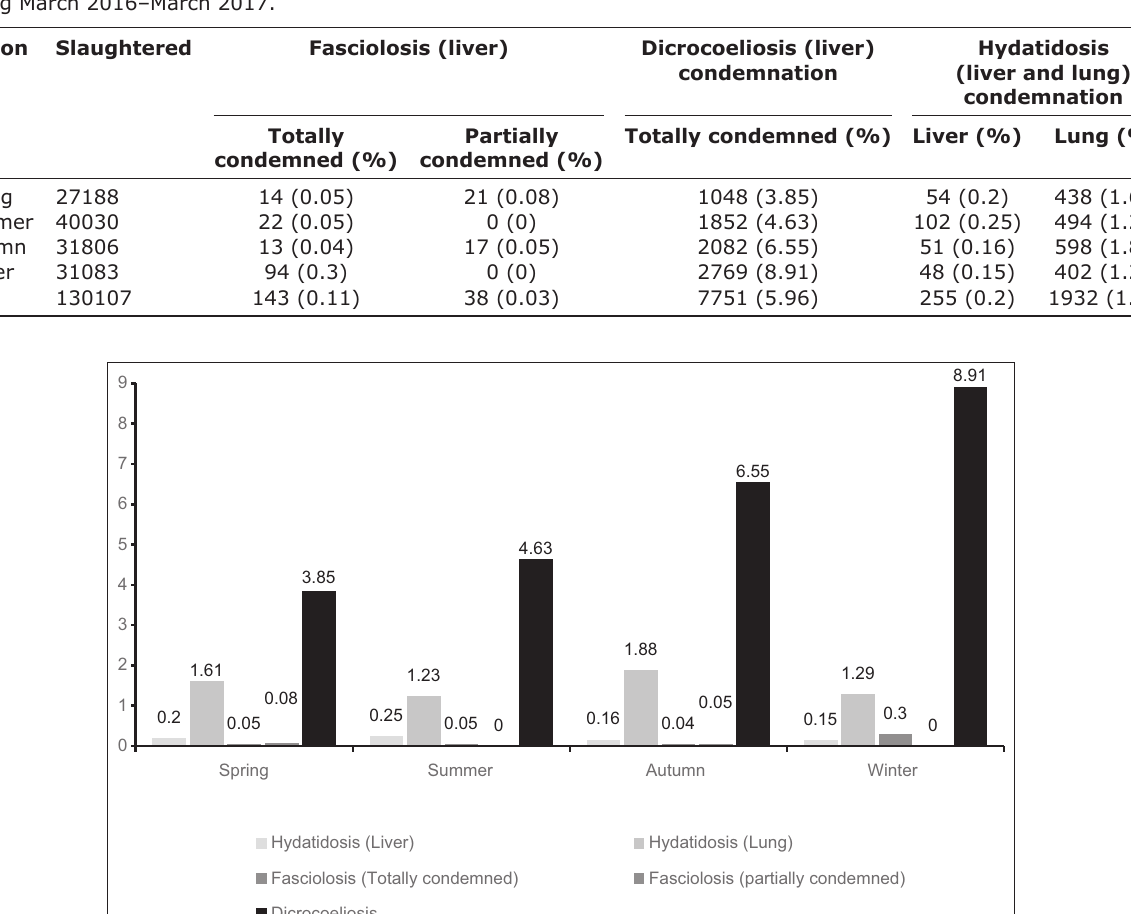
Table-1: Contamination abundance of fasciolosis, dicrocoeliosis, and hydatidosis in the slaughterhouse of Nishapour during March 2016–March 2017.